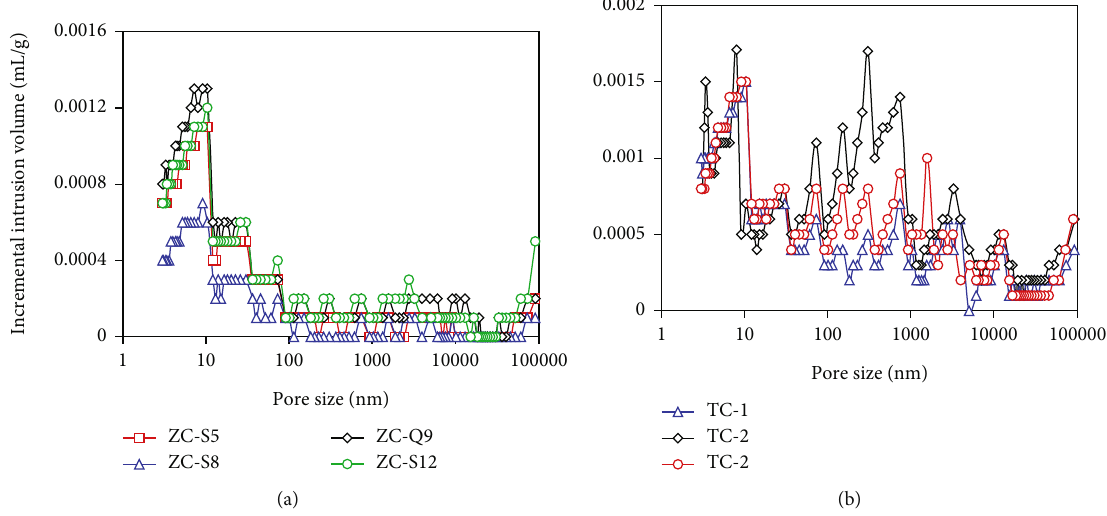
Figure 3: Relationship between incremental intrusion volume and pore size for nonoutburst coal samples (a) and outburst coal samples (b).